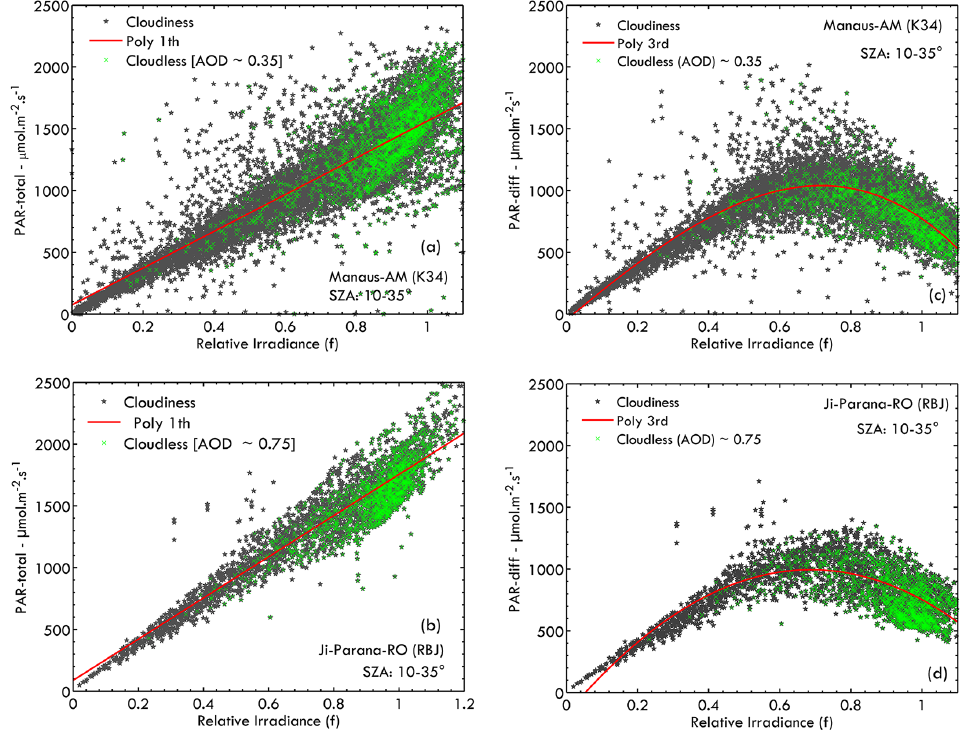
Figure 7. Relationships between total PAR and relative irradiance f for the K34 site (a) and RBJ (b) . The lower part shows the diffuse PAR versus relative irradiance f for K34 (c) and RBJ (d) sites. The periods of the data used are K34 site (2000–2009) and RBJ site